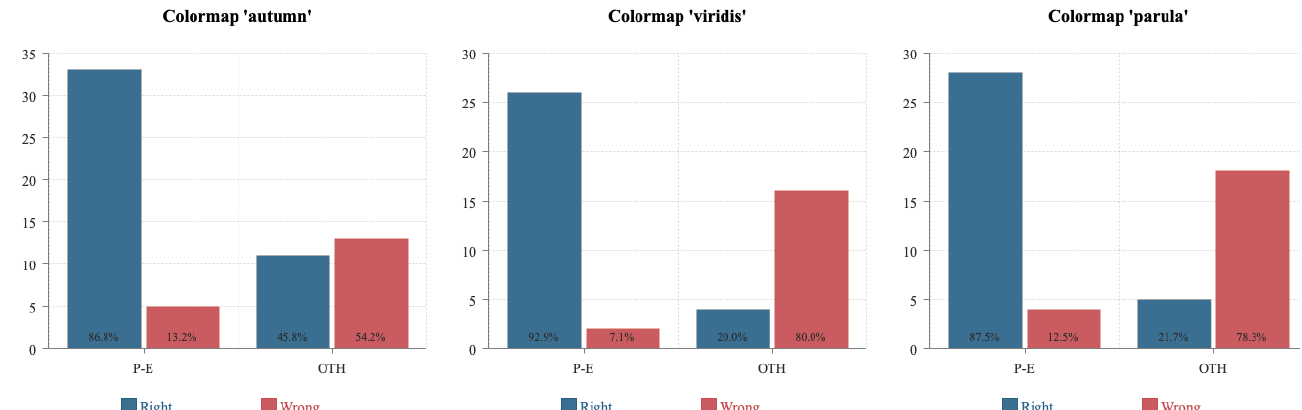
Figure 15. The analytic results for the three baseline colormaps autumn , viridis and parula . The X-axis represents the positive–exciting (P-E) and other quadrants (OTH) from the valence–arousal model. The Y-axis shows the number of participants who rated the designated colormap. Right: the number of people who rated the baseline colormap as desirable in the crowdsourced study in Part II. Wrong: the number of people who rated the baseline colormap as undesirable in the crowdsourced study in Part